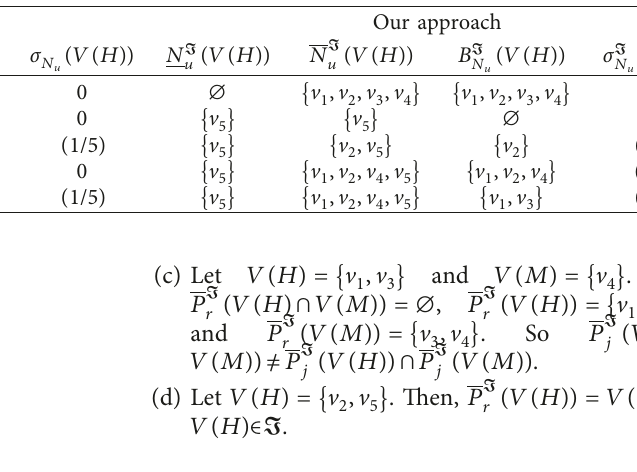
Table 1: Comparison between the lower approximations, upper approximations, j -boundary, and j -accuracy measures by using El Atik et al.’s approach [28] and our approach for j � u .